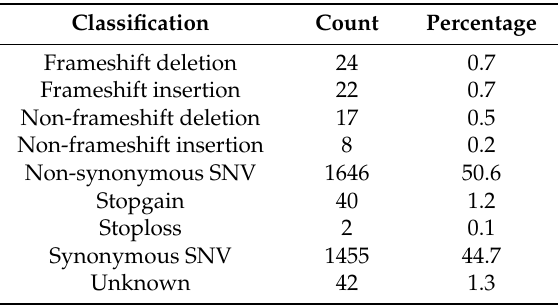
Table 3. Overview of the observed exonic alterations in breast cancer patients by coding